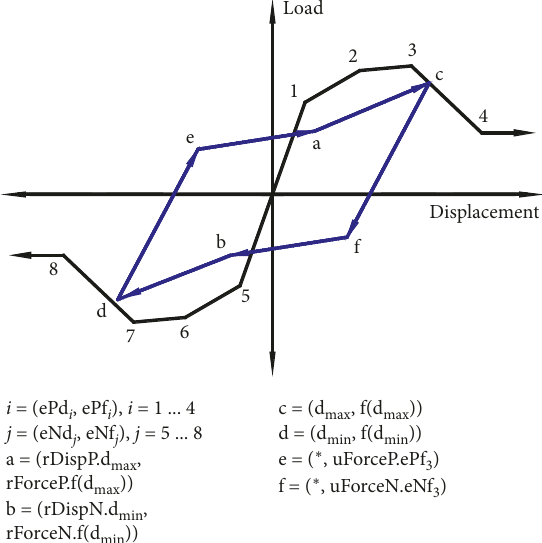
Figure 3: Pinching 4 model